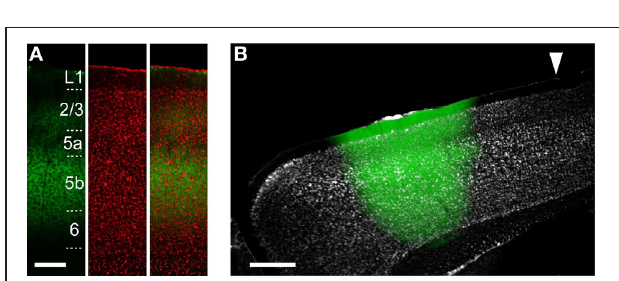
FIGURE 2 | ChR2 expression in ChR2 Tg and AAV-ChR2 mice. (A) Anti-GFP immunofluorescence (left), Nissl staining (middle), and the overlay (right) in the CFA in a sagittal section from a ChR2 Tg mouse. Scale bar, 200 µ m. (B) Overlay of EYFP fluorescence (green) and Nissl staining (gray) in a sagittal section of a mouse in which AAV-ChR2-EYFP was injected into the RFA. Arrowhead indicates 0mm anterior and 0.8mm lateral from the bregma. Scale bar, 500 µ